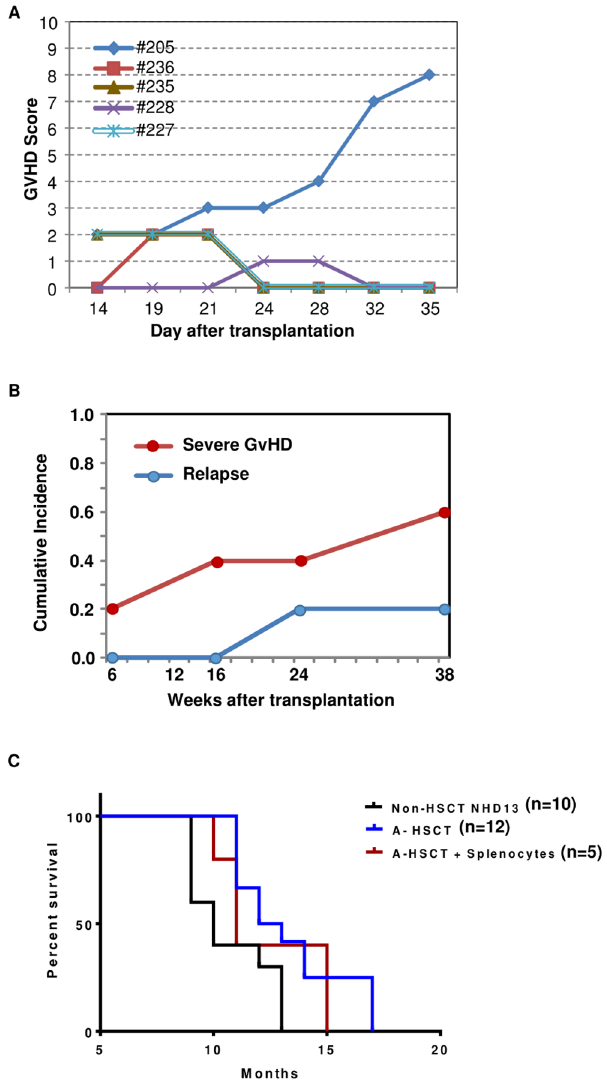
Fig 4. Effect of GVHD using the NHD13A-HSCT model. (A) GVHD was inducedby transplantation of splenocytes with BMNC. GVHD score vs time for individual recipients; the values for #227 and #235are identicaland thus the curves are superimposed on one another(B) Cumulative incidenceof severe GVHD or relapse. Mice were euthanized when they displayedclinical signs of diseasesuch as lethargy, tachypnea,or hunchedposture. (C) Survival curve comparisonof Non-HSCT NHD13, A-HSCT and A-HSCT + Splenocytes. Non-HSCT NHD13refers to NHD13transgenic mice not subjectedto irradiationand HSCT.